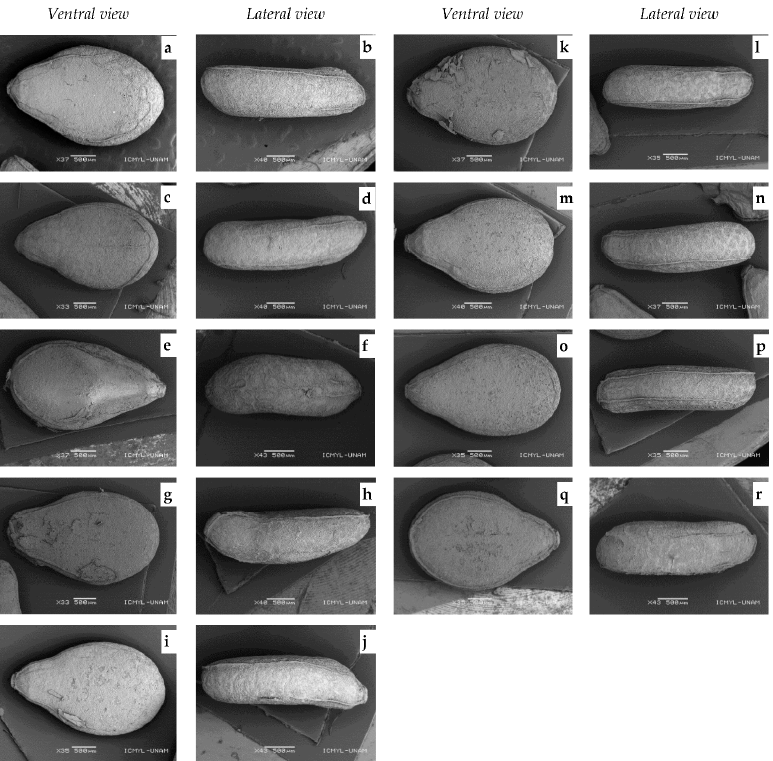
Figure 1. Micrographs of sesame seeds obtained by SEM, where ( a , b ) W; ( c , d ) CS0.1; ( e , f ) CS0.5; ( g , h ) CS1; ( i , j ) CSD; ( k , l ) CDA; ( m , n ) CD119; ( o , p ) CD071 and ( q , r ) A. The SEM images of bean seeds (Figure 2) showed that the coatings formed a contin- uous film for treatments CS0.1, CS0.5, CS1 and A, and in these treatments the porosities in the margin of the hilum were fully filled by the coating. On the other hand, the CSD and CDA treatments showed that chitosan flakes were adhered in a dispersed way. Fi- nally, for the CD119 and CD071 treatments, the images showed no adhesion of chitosan flakes to seed surface. The SEM images of coatings showed the ability of chitosan in solu- tion to form firm, homogeneous and continuous films.